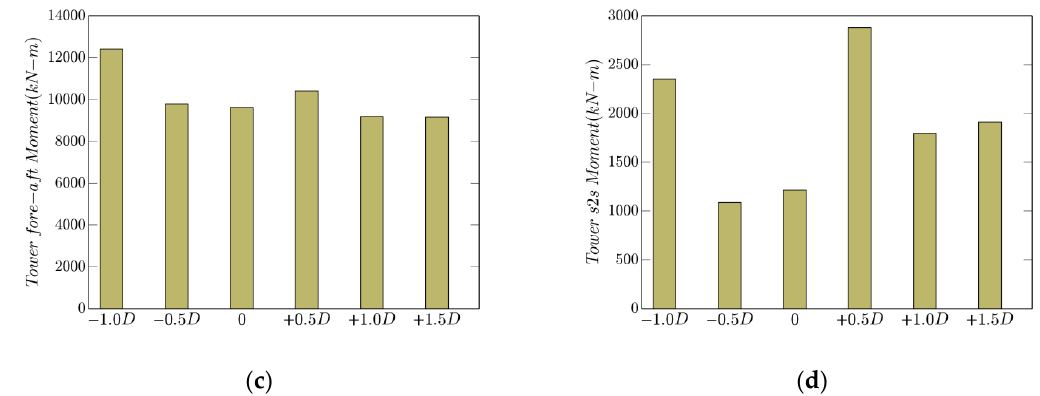
Figure 8. Damage equivalent loads for ( a ) flapwise blade root, ( b ) edgewise blade root, ( c ) tower fore-aft, and ( d ) tower side-to-side moments.